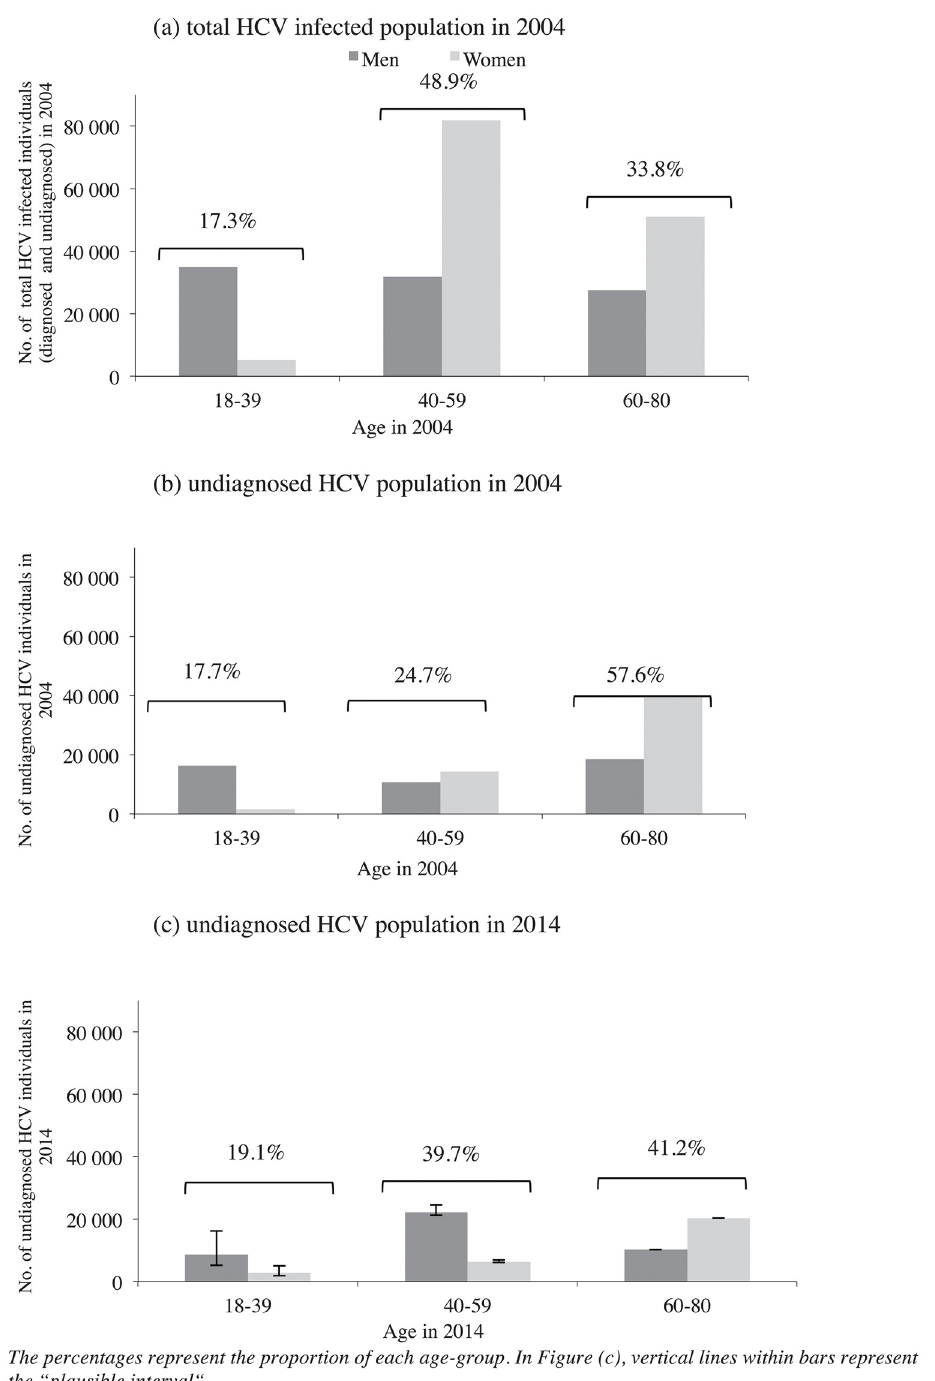
Fig 3. Age and gender estimated distributions of HCV chronically-infected population according to diagnosis and year, mainland France.